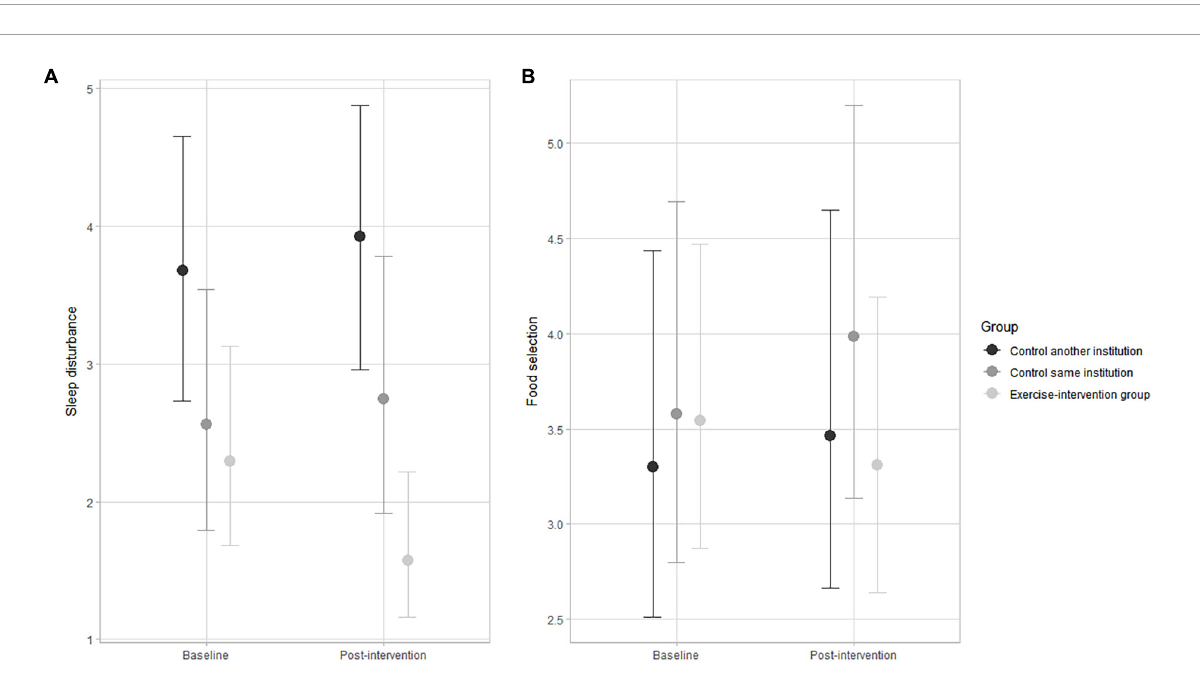
FIGURE4 Changes in sleep disturbance (A) and food selectivity (B) pre-and post-intervention in the exercise-intervention, same institution control, and another institution control groups. Error bars indicate the 95% credible